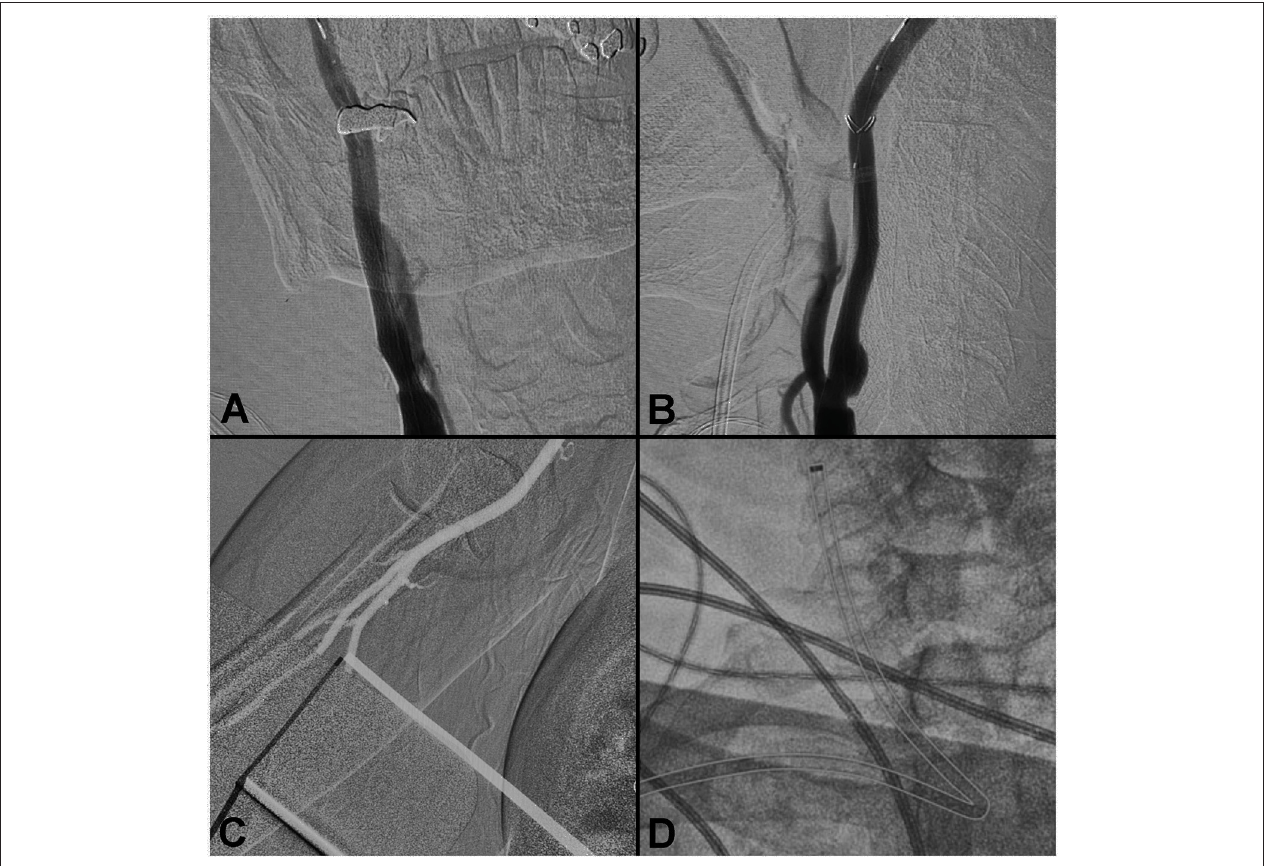
FIGURE 2 | Right carotid stenting—radial approach. (A,B) Pre-procedure angiogram demonstrating a right carotid web. (C) Radial artery. (D) Ballast position post-stenting (outlined).